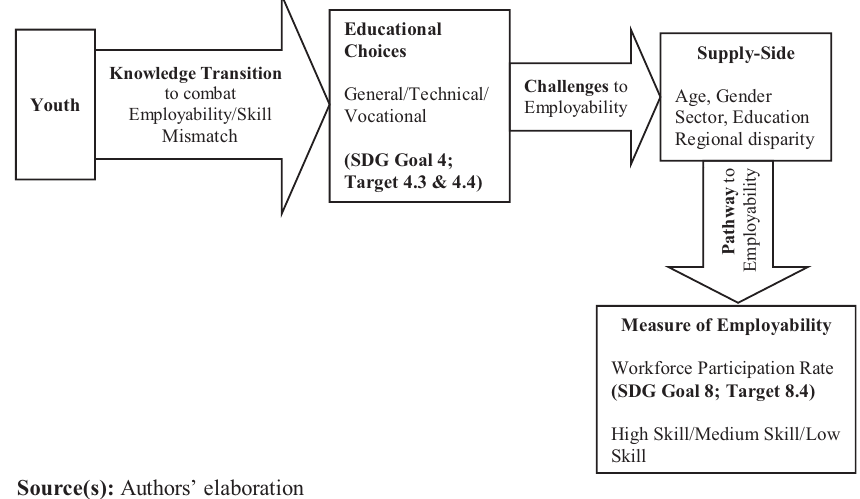
Figure 1. The conceptual framework: youth